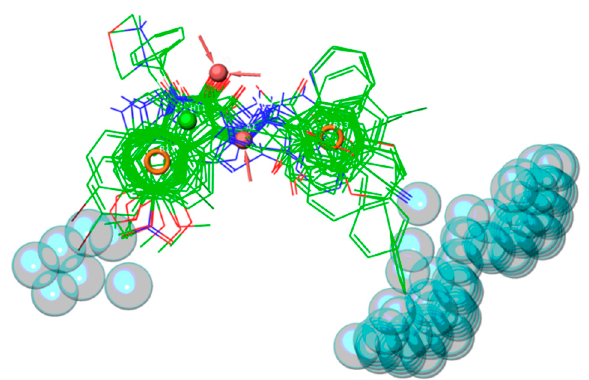
Figure 4. Overlay of the 36 new designed and prepared compounds, based on pharmacophore hypothesis AAHRR. Ligands are rendered as green wireframes.